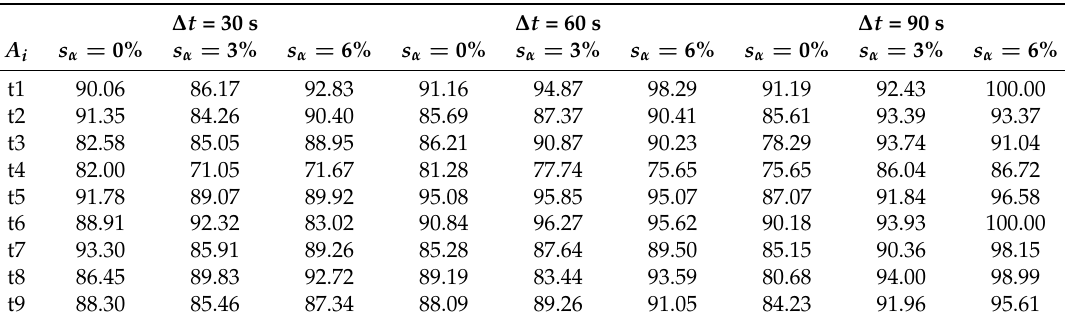
Table 2. Detailed values of metric F1-ii for each activity, duration of time-slot ∆ t and relevance factor s α